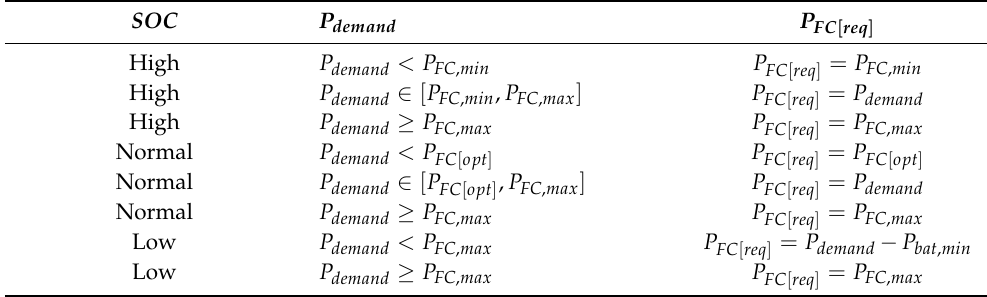
Table 1. Power distribution among the different sources of the system for an EMS based on an SMS. SOC P demand P FC [ req ] High P demand < P FC , min P FC [ req ] = P FC , min High P demand ∈ [ P FC , min , P FC , max ] P FC [ req ] = P demand High P demand ≥ P FC , max P FC [ req ] = P FC , max Normal P demand < P FC [ opt ] P FC [ req ] = P FC [ opt ] Normal P demand ∈ [ P FC [ opt ] , P FC , max ] P FC [ req ] = P demand Normal P demand ≥ P FC , max P FC [ req ] = P FC , max